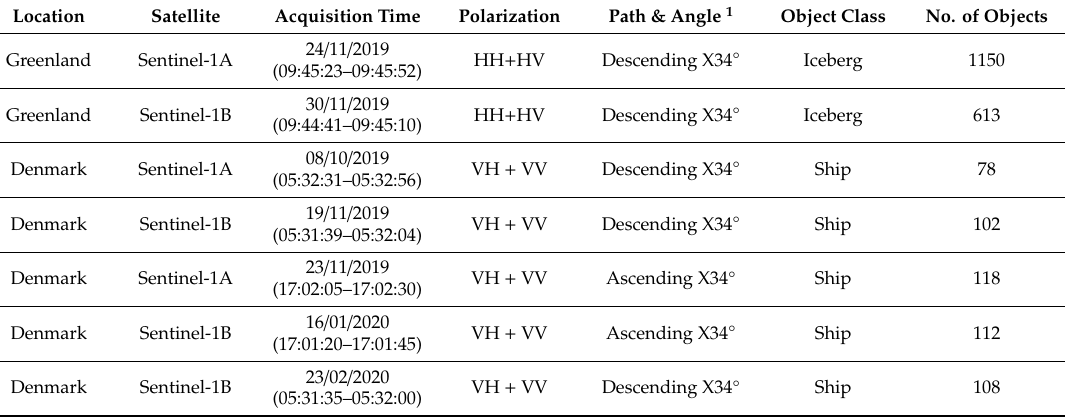
1 Incidence angle measured at mid